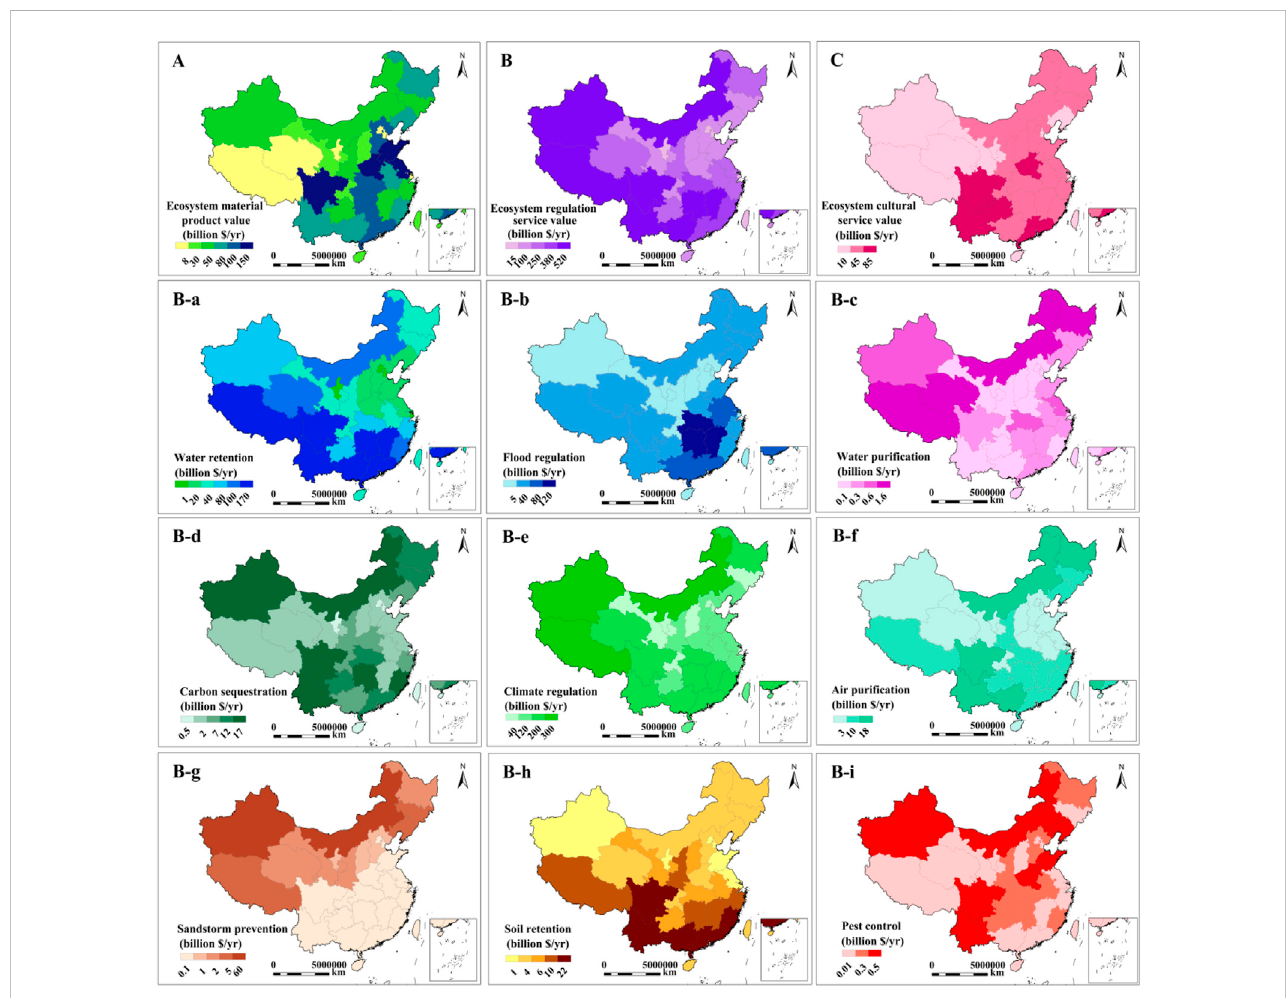
FIGURE 4 GEP accounting inChina (Ecosystem material product value, Regulation service value and Cultural service value). Note: (A) :Ecosystem material product value (EPV). (B) : Regulation service value (ERV), (B-a) : Water retention, (B-b) : Flood regulation, B-c: Water puri fi cation, (B-d) : Carbon sequestration, (B-e) : Climate regulation, (B-f) : Air puri fi cation, (B-g) : Sandstorm prevention, (B-h) : Soil retention, (B-i) : Pest control. (C) : Cultural service value (ECV). Main references (Fengetal.,2013;Xiaoetal.,2014;Xieetal.,2015;Pemaetal.,2017;Wang etal., 2017;Panetal.,2018;Dong